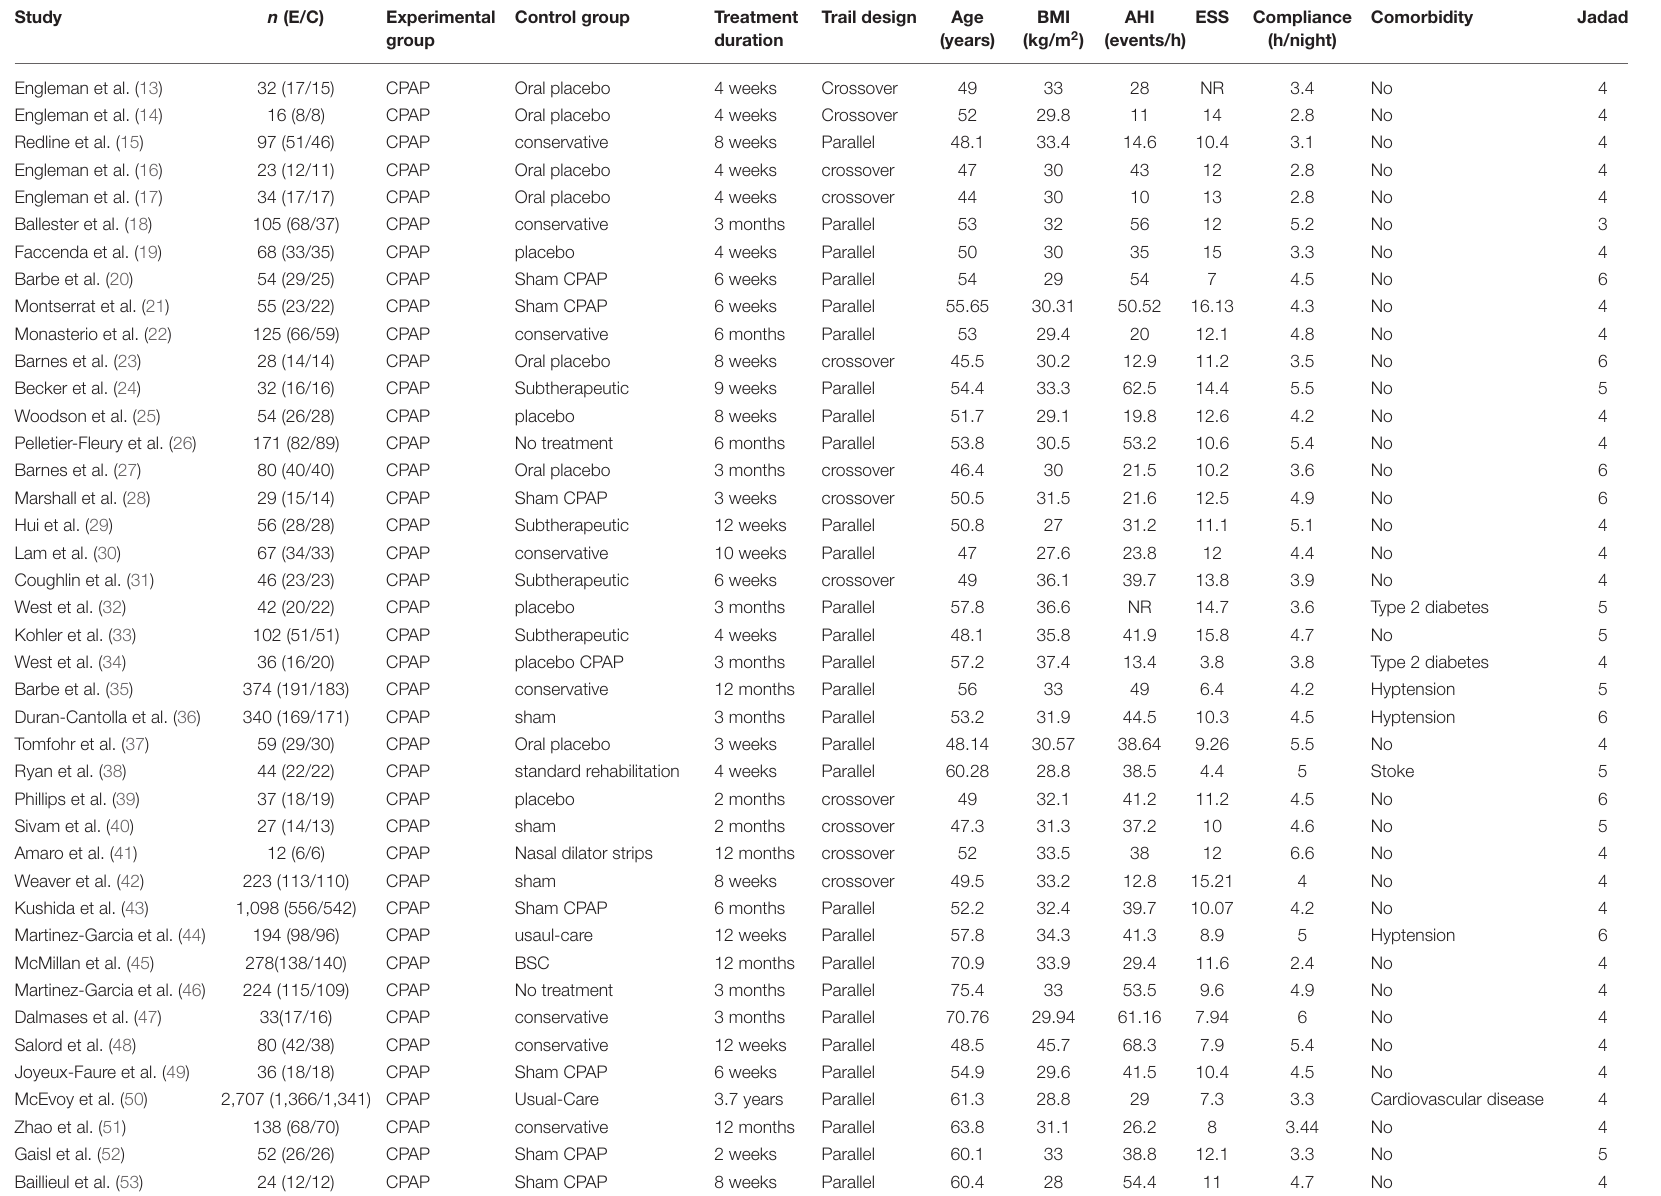
TABLE 1 | Basic characteristics of patients and studies included in the